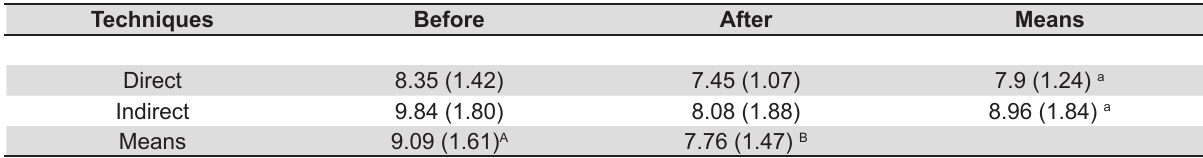
Different superscripted uppercase letters indicate statistically different means within each column; different superscript lowercase letters indicate statistically different means within each row.